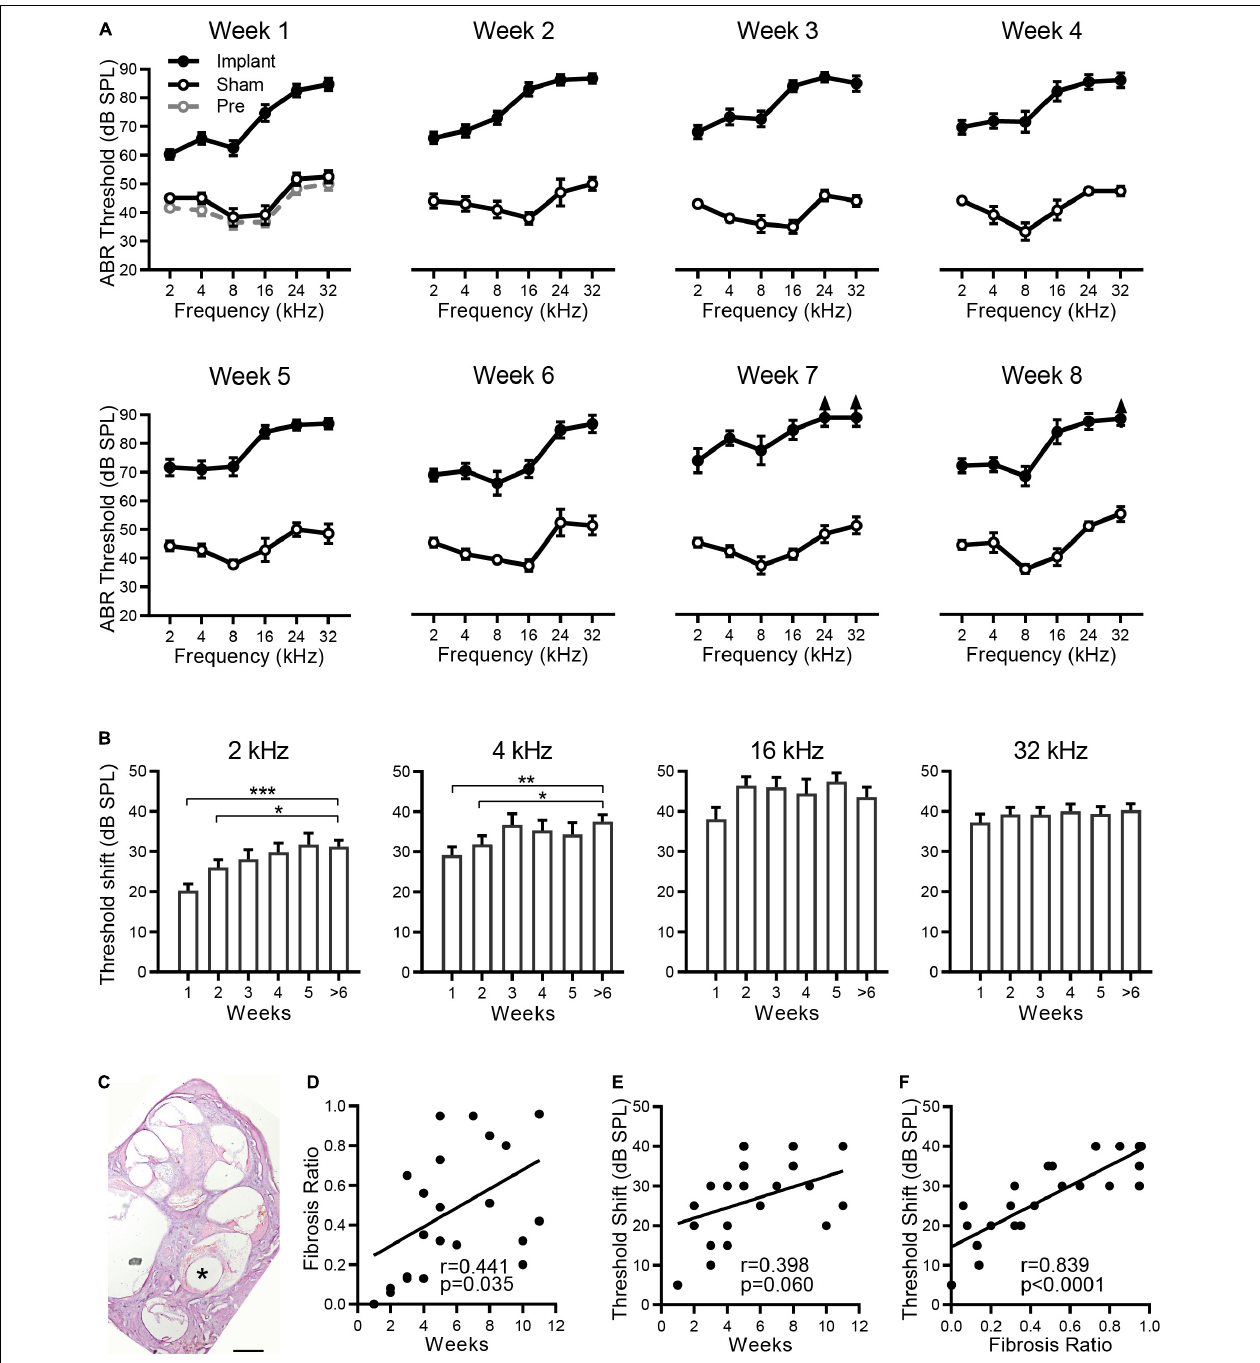
FIGURE 1 | Hearing loss is associated with fibrosis after CI. (A) The effects of electrode implantation on the ABR thresholds at different implantation times. The ABR threshold-frequency curves of the implant (filled circles) and sham groups (open circles) were plotted in the same panel from week 1 to week 8. For the implant group, n = 18, 20, 21, 18, 21, 7, 5, and 11 for weeks 1 to 8, respectively. For the sham group, n = 6 for each week. The ABR thresholds before implantation (Pre-Op, gray open circles, n = 6) are plotted in the panel of week 1. The data are presented as the mean ± SE. For some data points, the arrows indicate the thresholds above the limit of measurement (90 dB SPL). (B) ABR threshold shifts at 2, 4, 16, and 32 kHz versus the sham group at different implantation times. Data are presented as the mean and SE. * p < 0.05; ** p < 0.01; *** p < 0.001. n = 18, 20, 21, 18, 21, and 23 for weeks 1, 2, 3, 4, 5, and > 6, respectively. (C) Optical microscope image of a representative H&E-stained cross section of a rat cochlea implanted with electrode for 5 weeks. “*” indicates the trajectory of the electrode insertion. Scale bar = 500 µ m. The percentage of fibrous tissue in scala tympani was determined as fibrosis ratio. (D,E) The pooled data show the proliferative tissue volume (D) and the ABR threshold shifts at 2 kHz (E) distributed over the implantation time. (F) The relationship between ABR threshold shifts and proliferative tissue volume. The line indicates the linear correlation coefficient.